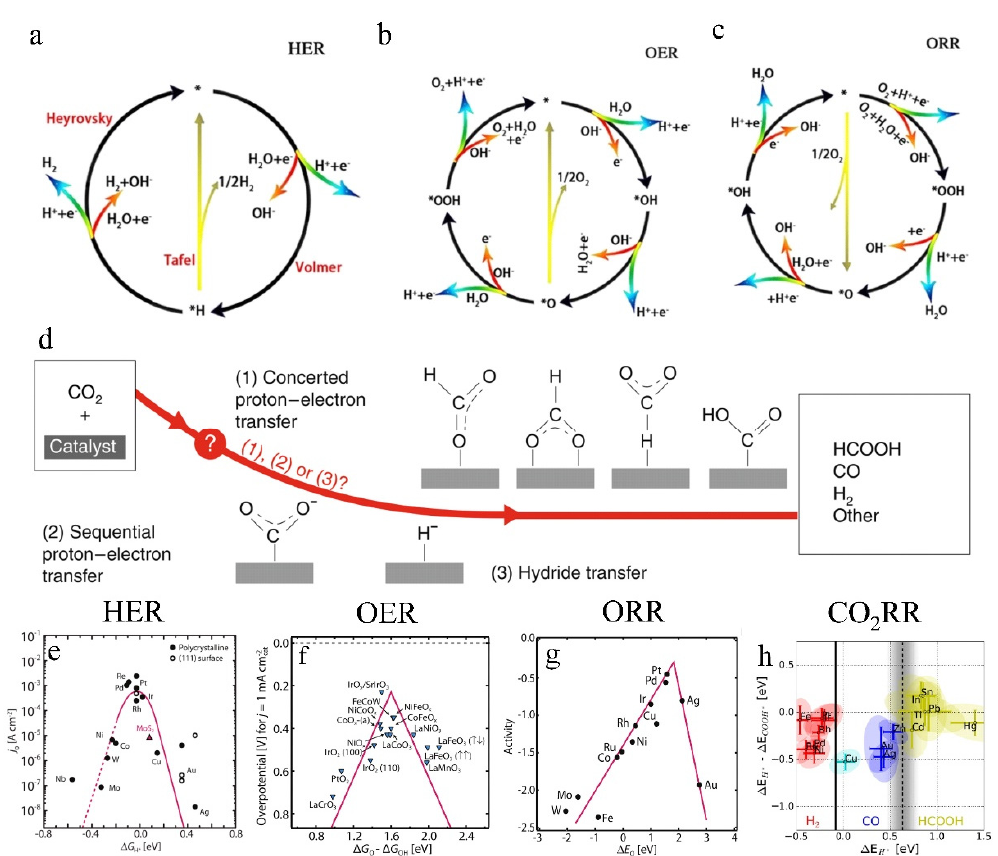
Figure 2. ( a ) HER mechanism in acid (blue line) and alkaline (red line) electrolytes. ( b ) OER mechanism in acid (blue line) and alkaline (red line) electrolytes. ( c ) ORR mechanism in acid (blue line) and alkaline (red line) electrolytes. Reproduced with permission [8]. Copyright 2020, Elsevier Ltd., Amsterdam, Netherlands. ( d ) CO 2 RR mechanism. Reproduced with permission [24]. Copyright 2019, Nature Publishing Group. ( e ) HER volcano plot for metals and MoS 2 . ( f ) OER volcano plot for metal oxides. ( g ) ORR volcano plot for metals. Reproduced with permission [17]. Copyright 2017, American Association for the Advancement of Science. ( h ) CO 2 reduction